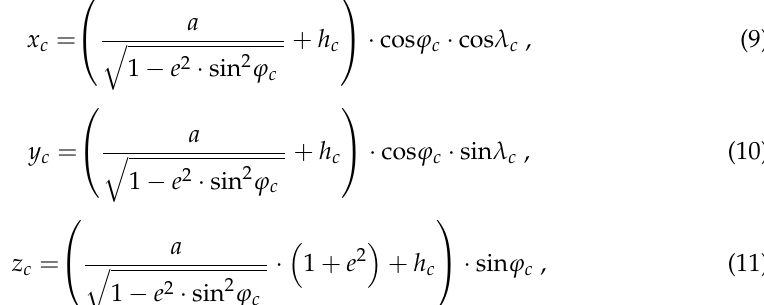
(cid:0) (cid:1) e C , e C , e C relative to the base 2 3 1